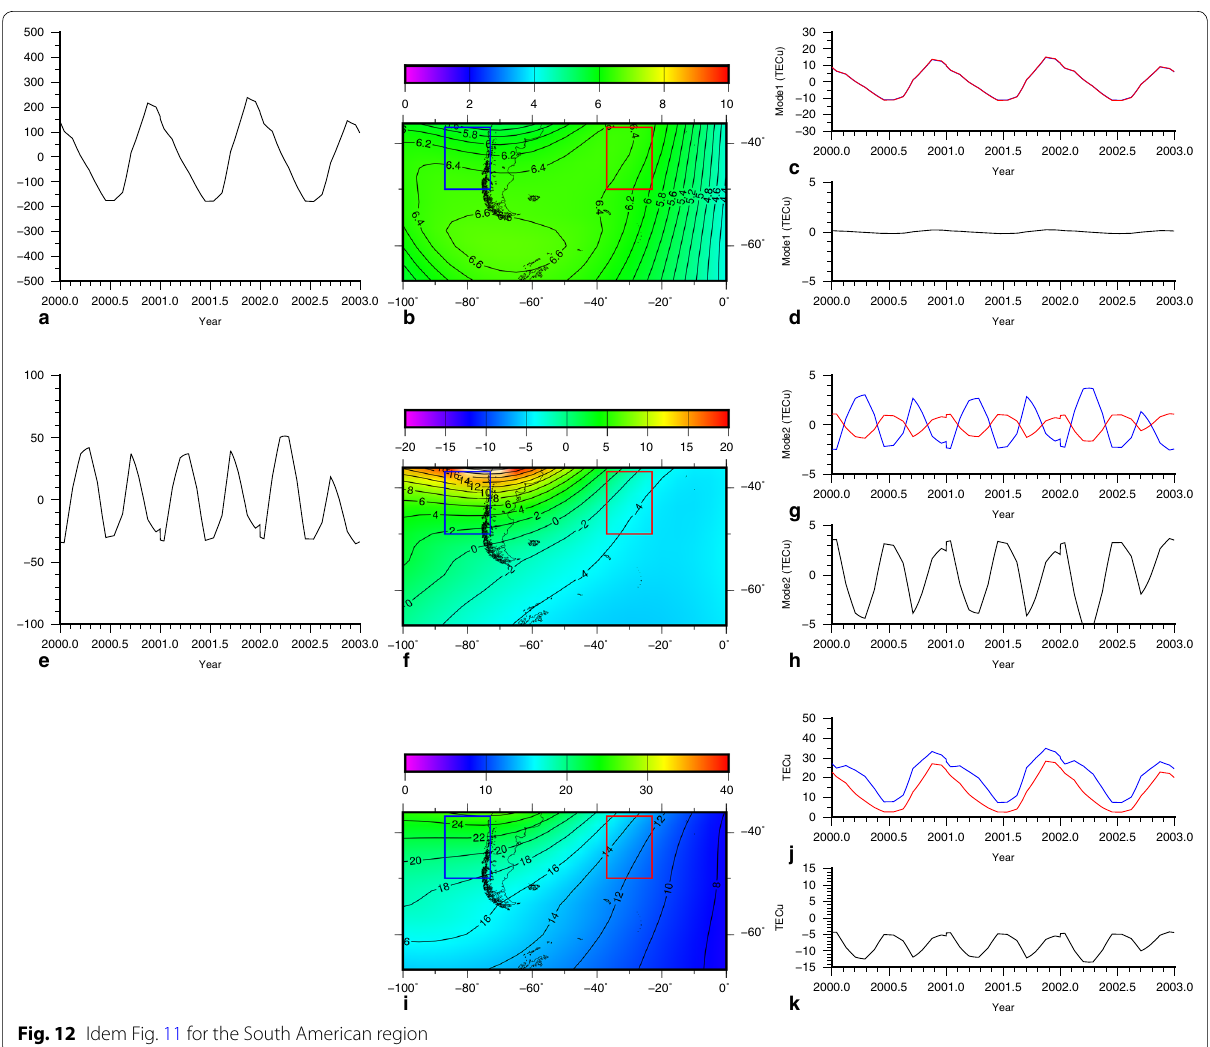
Fig. 12 Idem Fig. 11 for the South American